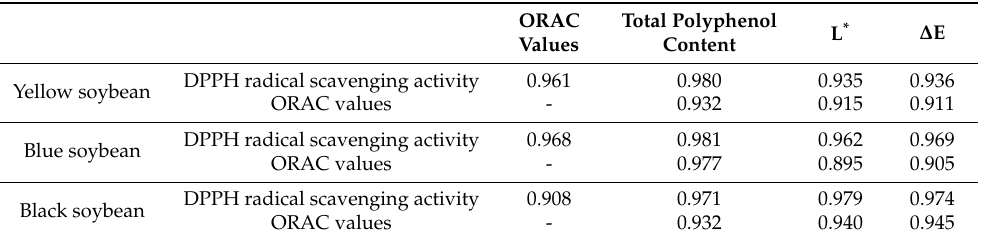
Table 3. Determination coefficients of linear regression analysis in combination of the two among antioxidant activity, total phenol content and color values.